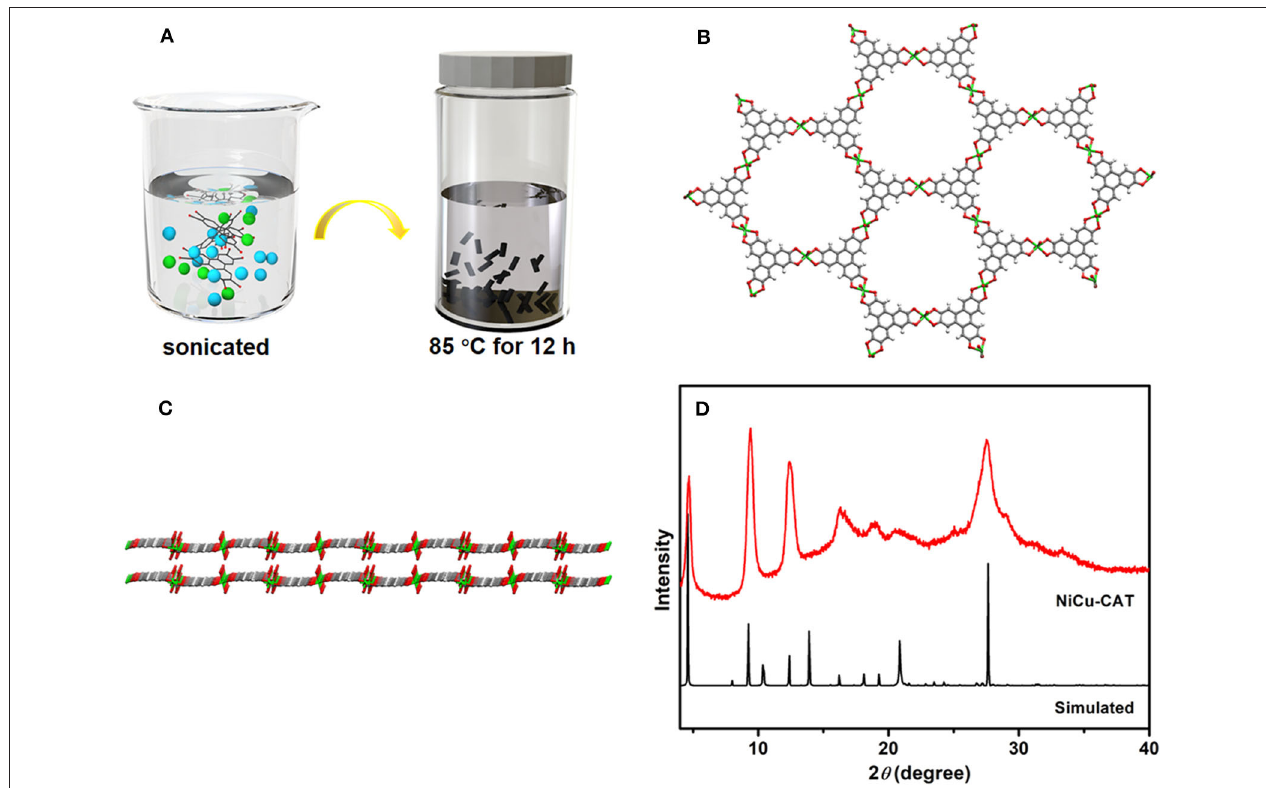
FIGURE 1 | (A) Schematic illustration of the preparation of NiCu-CAT. (B) Connecting mode of HHTP molecules and Ni 2 + and Cu 2 + ions. (C) View of the two extended corrugated layers along the [110] direction. (D) XRD pattern of NiCu-CAT nanocrystal and